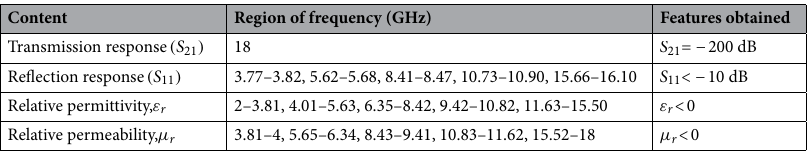
Table 4. Effective factors of the recommended MAA unit cell.